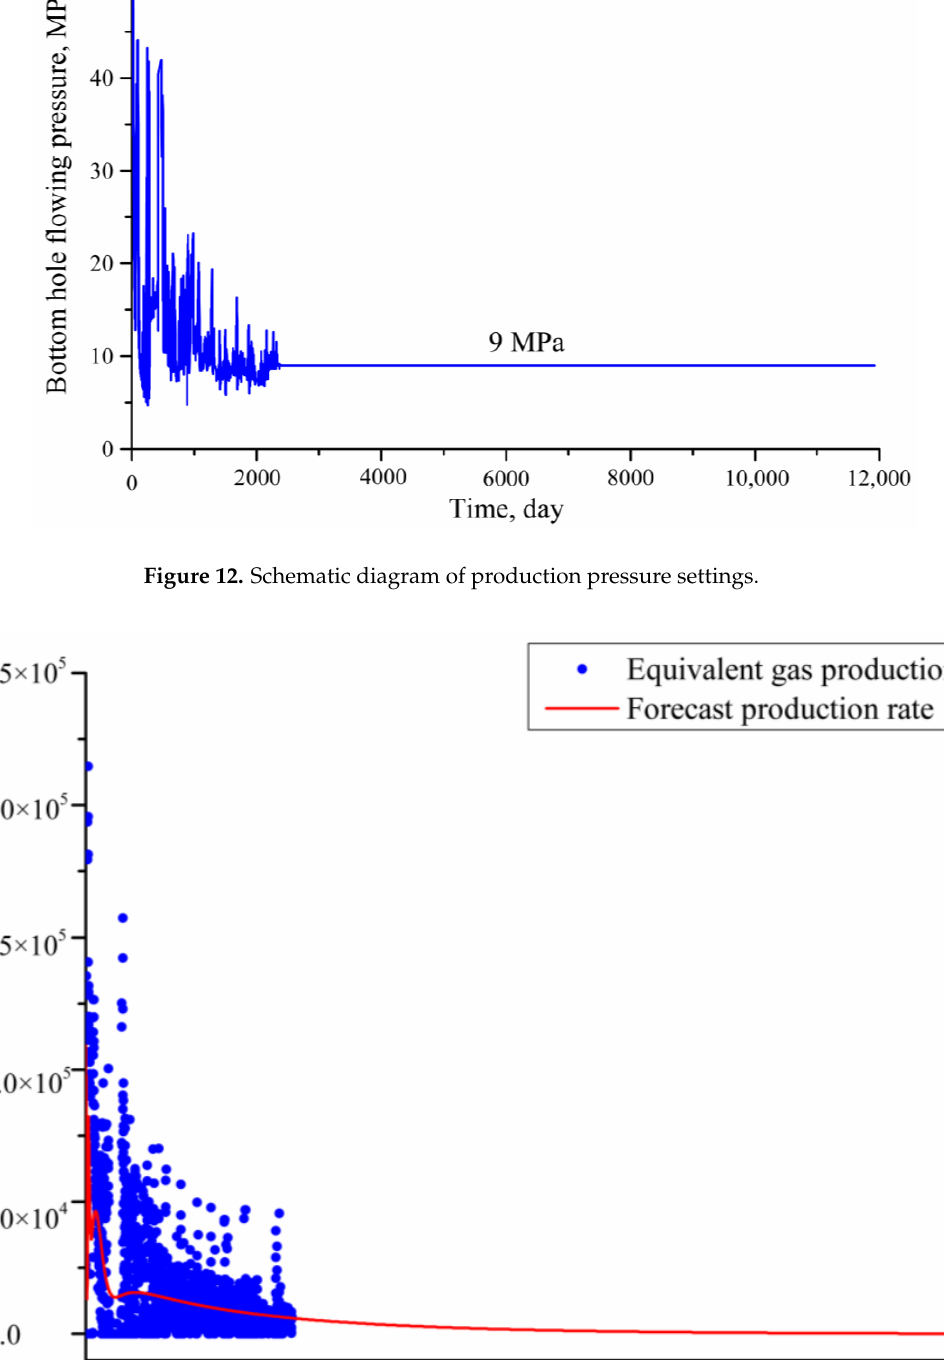
Figure 13. The fitting effect between the equivalent gas production calculated by the mathematical model and the real equivalent gas production.